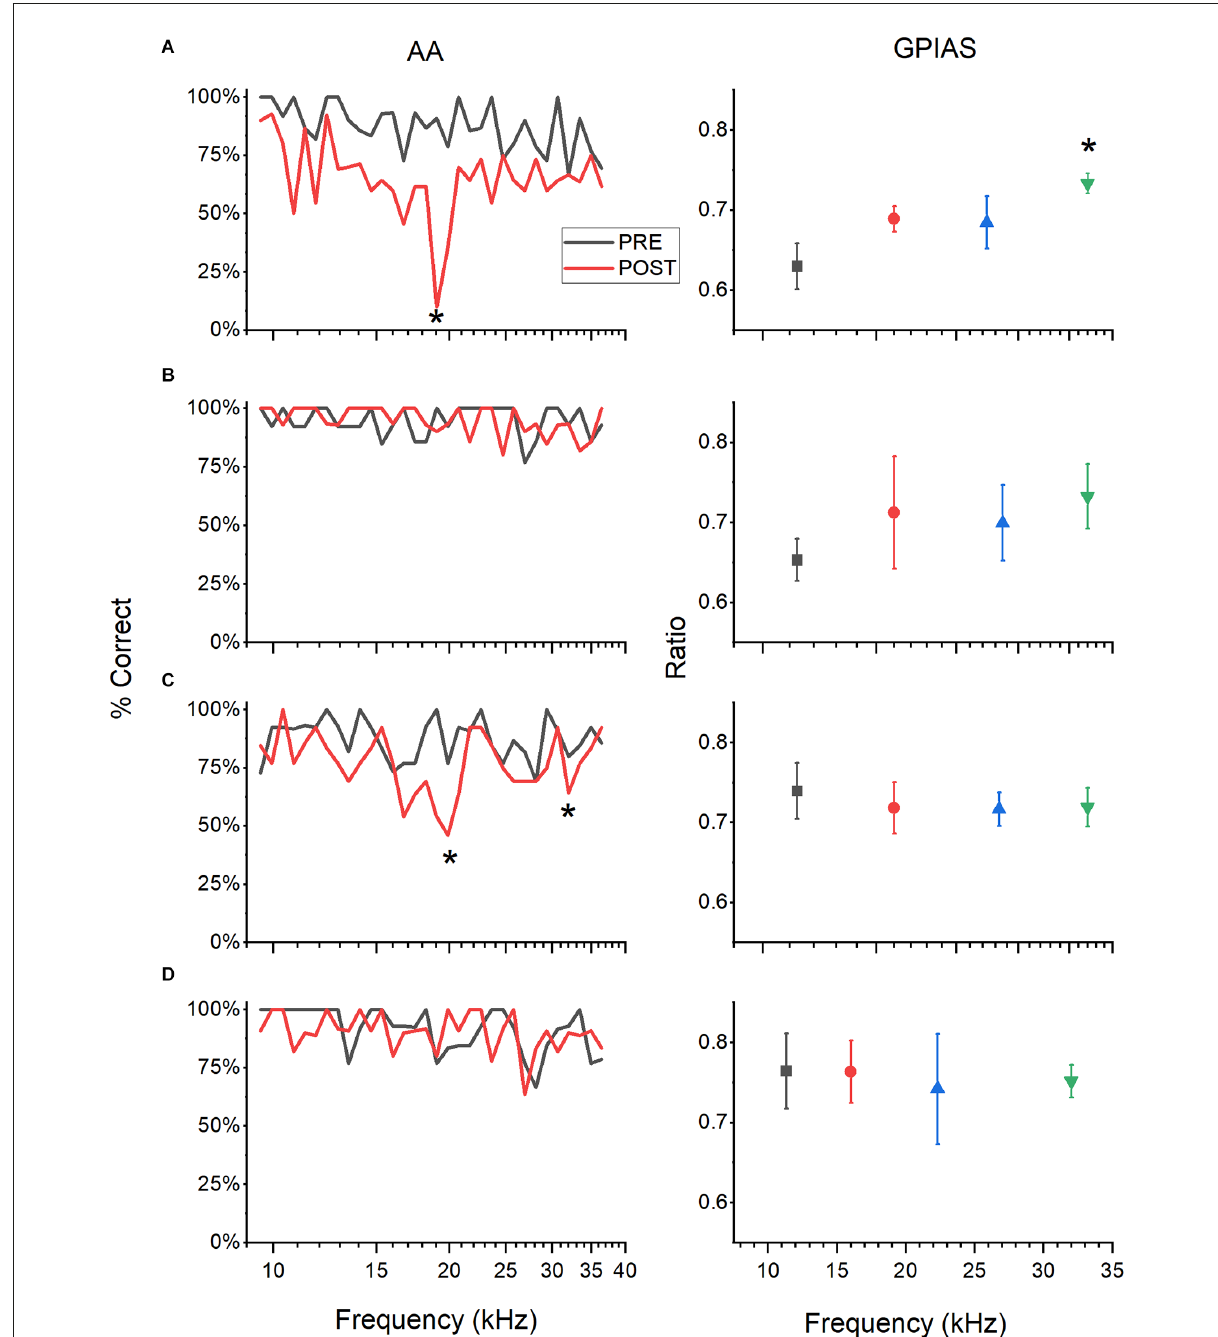
FIGURE2 Examples of tinnitus behavior. GPIAS and AA results represented graphically for four example mice. AA results (left panels) show the percent successful avoidance averaged over five session POST sound exposure (red) and PRE (black) for comparison. GPIAS results (right panels) show the modified ratios (greater of GAP: NO GAP and NO GAP: GAP) of startle RMS at each of the four frequencies tested POST sound exposure over five testing sessions. Each row is one animal. (A) Animal has a significantly higher modified ratio at 32 kHz (One way ANOVA with Tukey test, p = 0.04). AA results show one frequency of deficit at 19.027 kHz (one sample t -test, p = 0.002). This animal is A+/G+. (B) Animal has no significant differences between frequencies for both GPIAS and AA testing. This animal is A − /G − . (C) Animal has behavioral evidence of tinnitus at 19.8 and 32 kHz in AA ( p = 0.004 and p = 0.009 respectively, one sample t -test) but not in GPIAS. This animal is A+/G − . (D) Animal has behavior consistent with tinnitus at 16 kHz in GPIAS (one way ANOVA with Tukey test, p = 0.027), but no significant differences in AA. This animal is A − /G+. For the GPIAS data, only the POST results are shown, but for AA PRE and POST are shown. Statistics to determine the tinnitus frequency were done on POST data alone to help remove any effect that hearing loss may have on performance. * P <